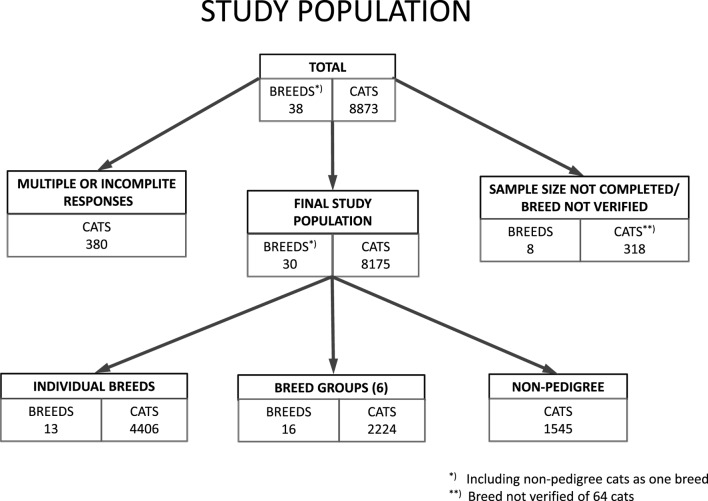
Population flow chart: cats selected into the study from responses submitted into the feline health study.